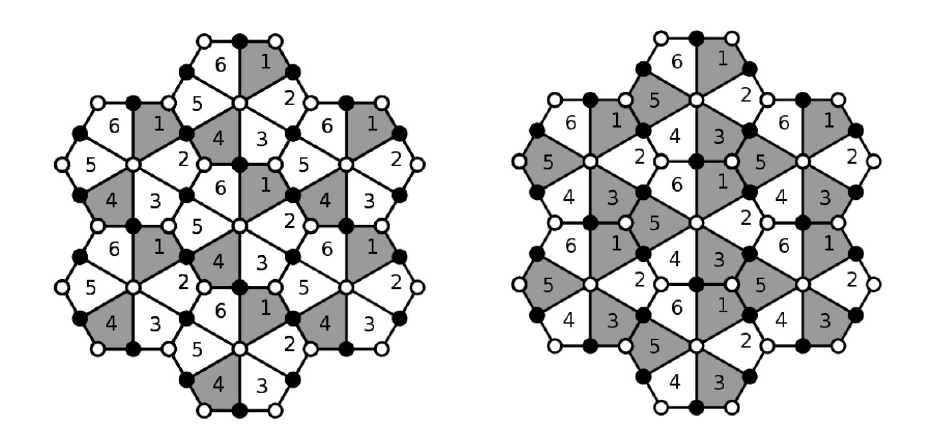
Figure 20 . The dimer of the dP 3 singularity, which admits both classes of deformation branes. Left (cid:12)gure: deformation fractional branes corresponding to isolated nodes. Right (cid:12)gure: deformation fractional branes corresponding to loops in the quiver.